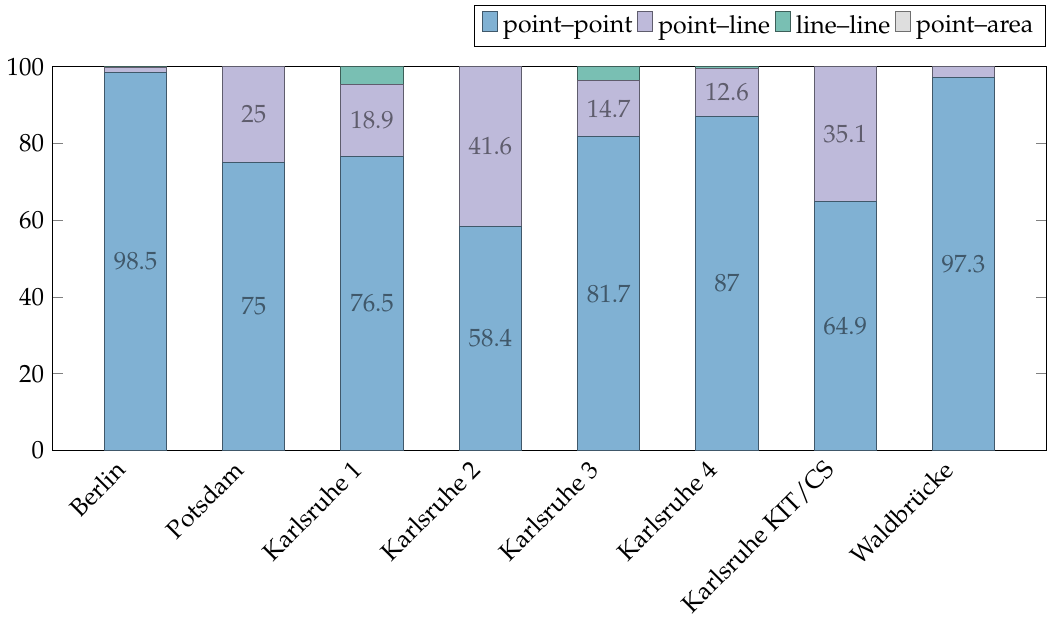
Figure 6. Intersection matrices when intersection is a